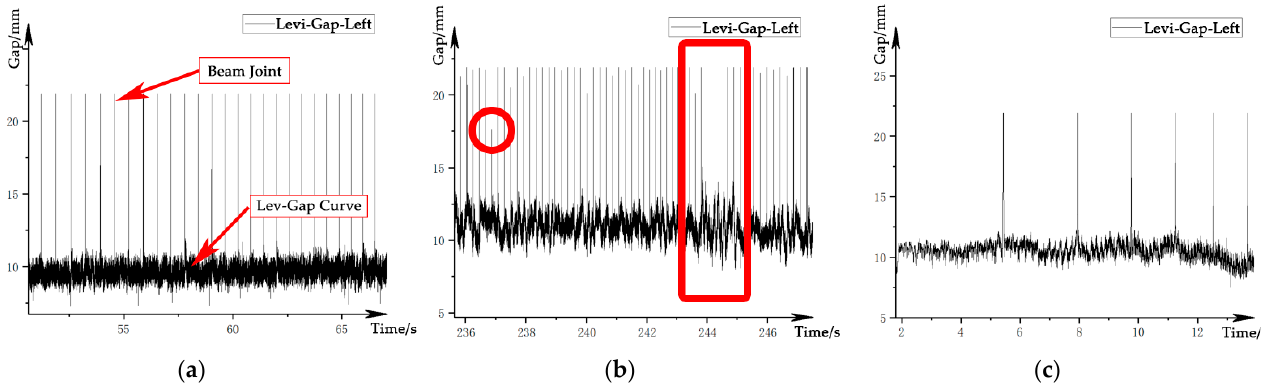
Figure 3. Waveform of the levitation gap signal: ( a ) ideal signal; ( b ) structure-affected signal; ( c ) velocity-affected signal.